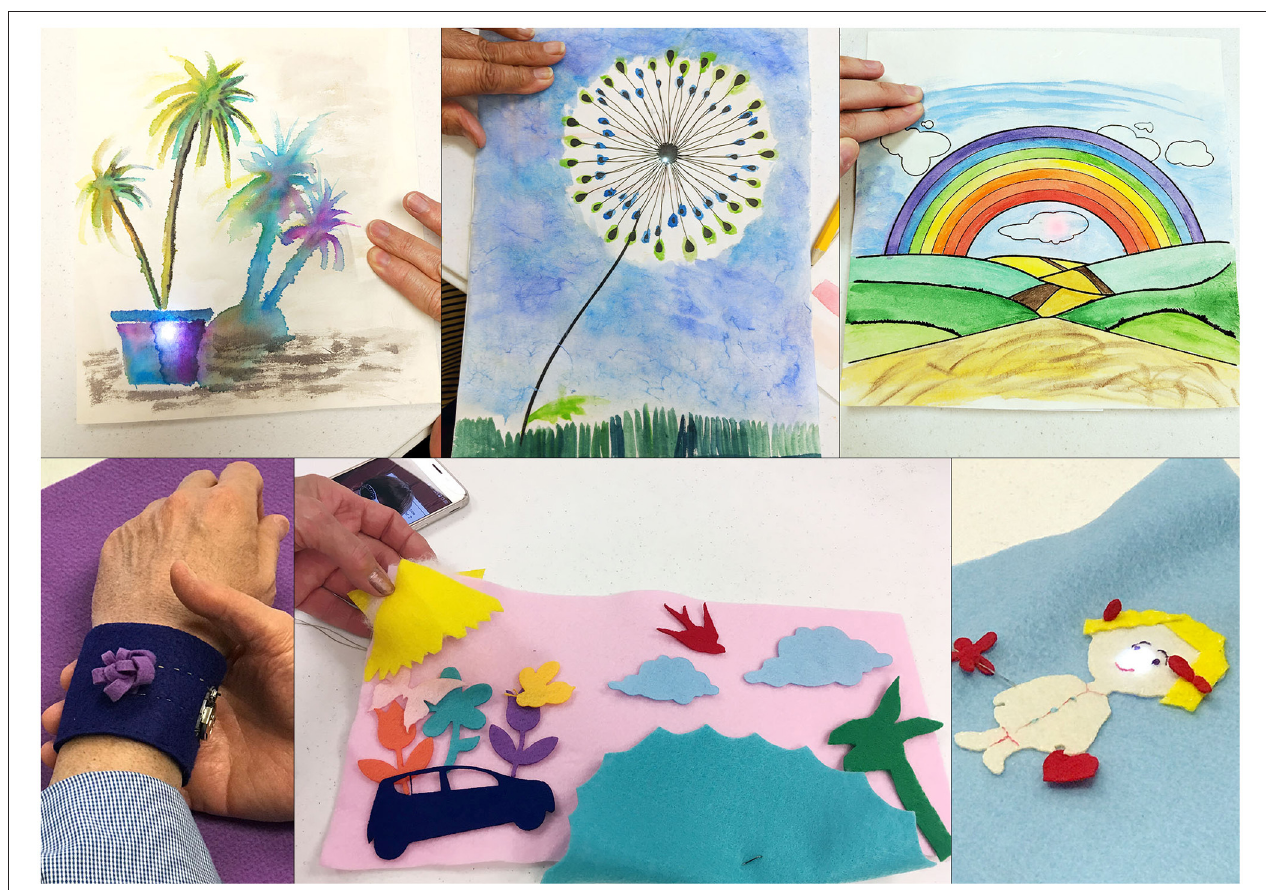
FIGURE 3 | Light-up paintings and soft ornaments created by